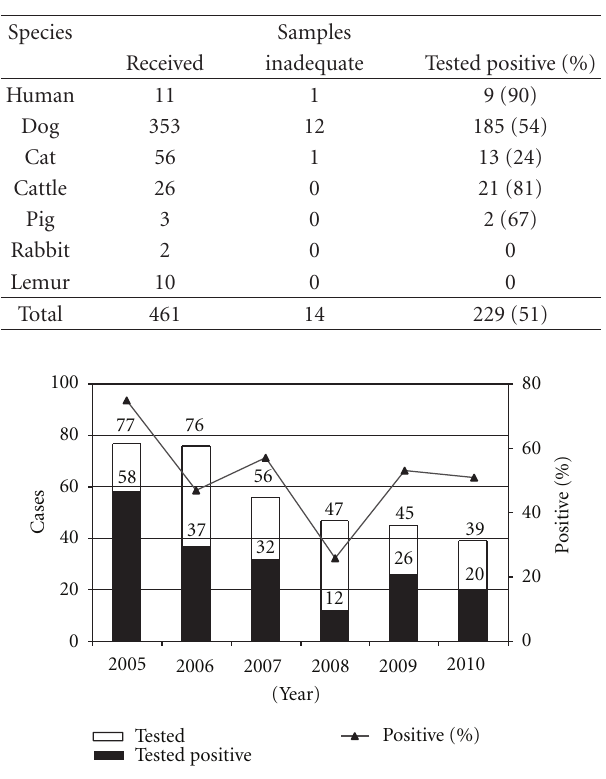
Figure 1: Rabies laboratory diagnostic in dogs, Madagascar, 2005–